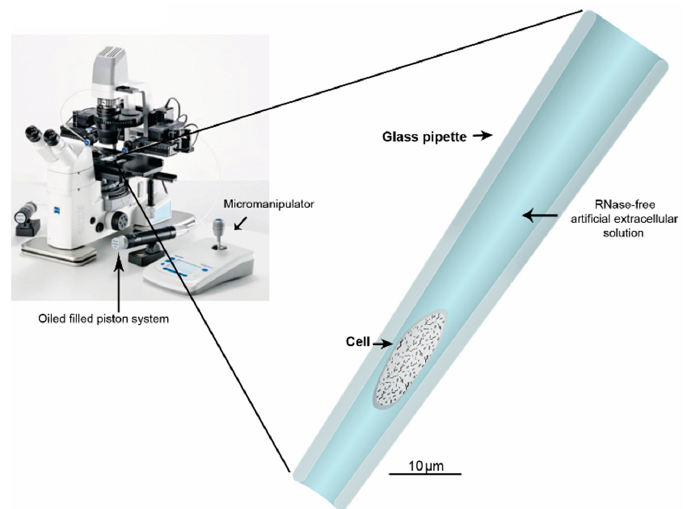
Figure 4. Harvesting of single cells in culture. The technique provides an economical and simple to use platform for harvesting single dissociated cells in culture. ( Left ) The cells are monitored under a microscope; ( Right ) using a glass pipette connected to a micromanipulator single cells can be collected relatively easily and transferred to a new tube for lysis and cDNA synthesis. The photograph of a typical microscope set-up is modified from Eppendorf.